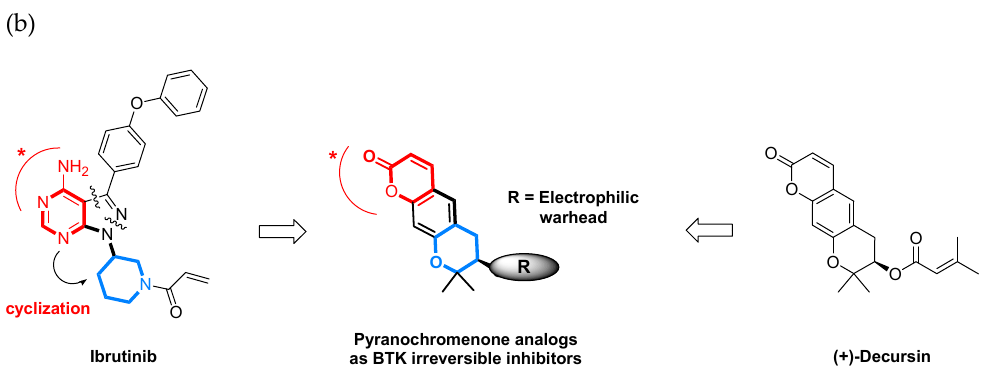
Figure 3. ( a ) Superposition of a docked pose of decursin (magenta) and the crystal structure of ibrutinib (green) in the active site of BTK (PDB code: 5P9J); ( b ) design of novel irreversible pyranochromenone-based BTK inhibitors. * Interacting groups at the hinge region.